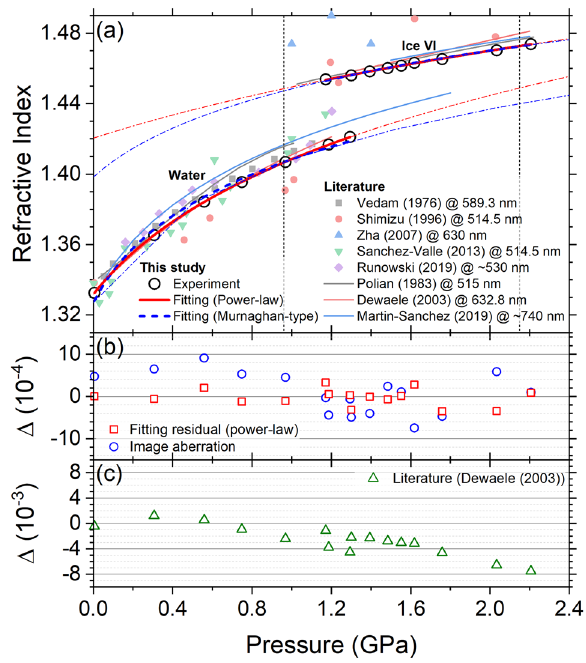
Figure 6. ( a ) Refractive index of H 2 O in liquid and ice VI phases measured at 532 nm in this study with literature values 12–14,17–20,39 . Our dataset is fitted with power-law 12 and Murnaghan-type 19 models (red solid and blue dashed lines) and the fitting curves are extrapolated to 0 and 2.4 GPa (thin red and blue dash-dotted lines). Equilibrium pressure levels for water-to-ice VI and ice VI-to-ice VII transitions (0.96 and 2.15 GPa at 25 ◦ C 40 ) are indicated with black dotted vertical lines. Error for pressure is 0.03 GPa. Random and systematic errors for 4 4 the index are 10 − and 5 × 10 − , respectively. ( b , c ) The differences of our data from the power-law fitting curve (red square), the recalculated index using another correction relation for the image aberration r ′ ab (see section “Image aberration”, blue circle), and the literature result 12 (green triangle).